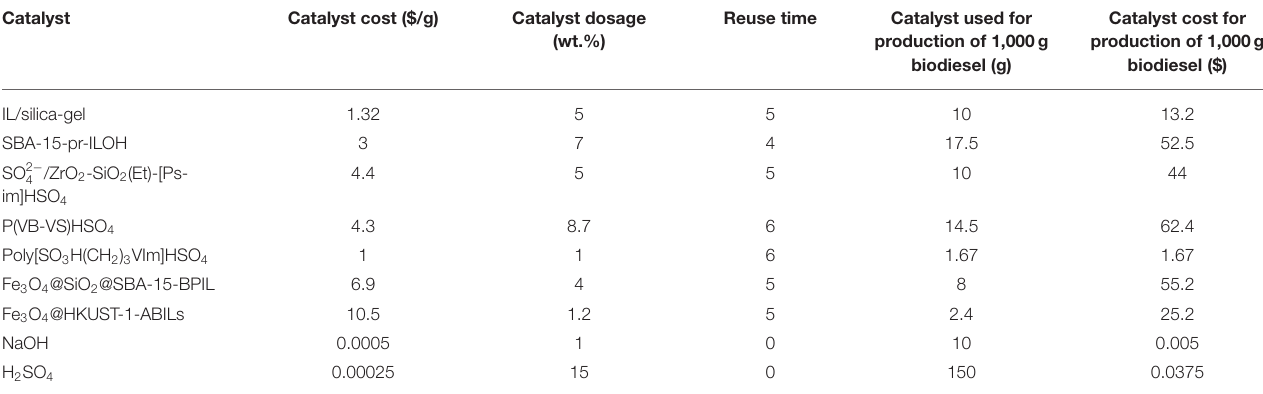
TABLE 5 | Estimation of synthesis cost for various types of heterogeneous ILs. Catalyst Catalyst cost ($/g) Catalyst dosage